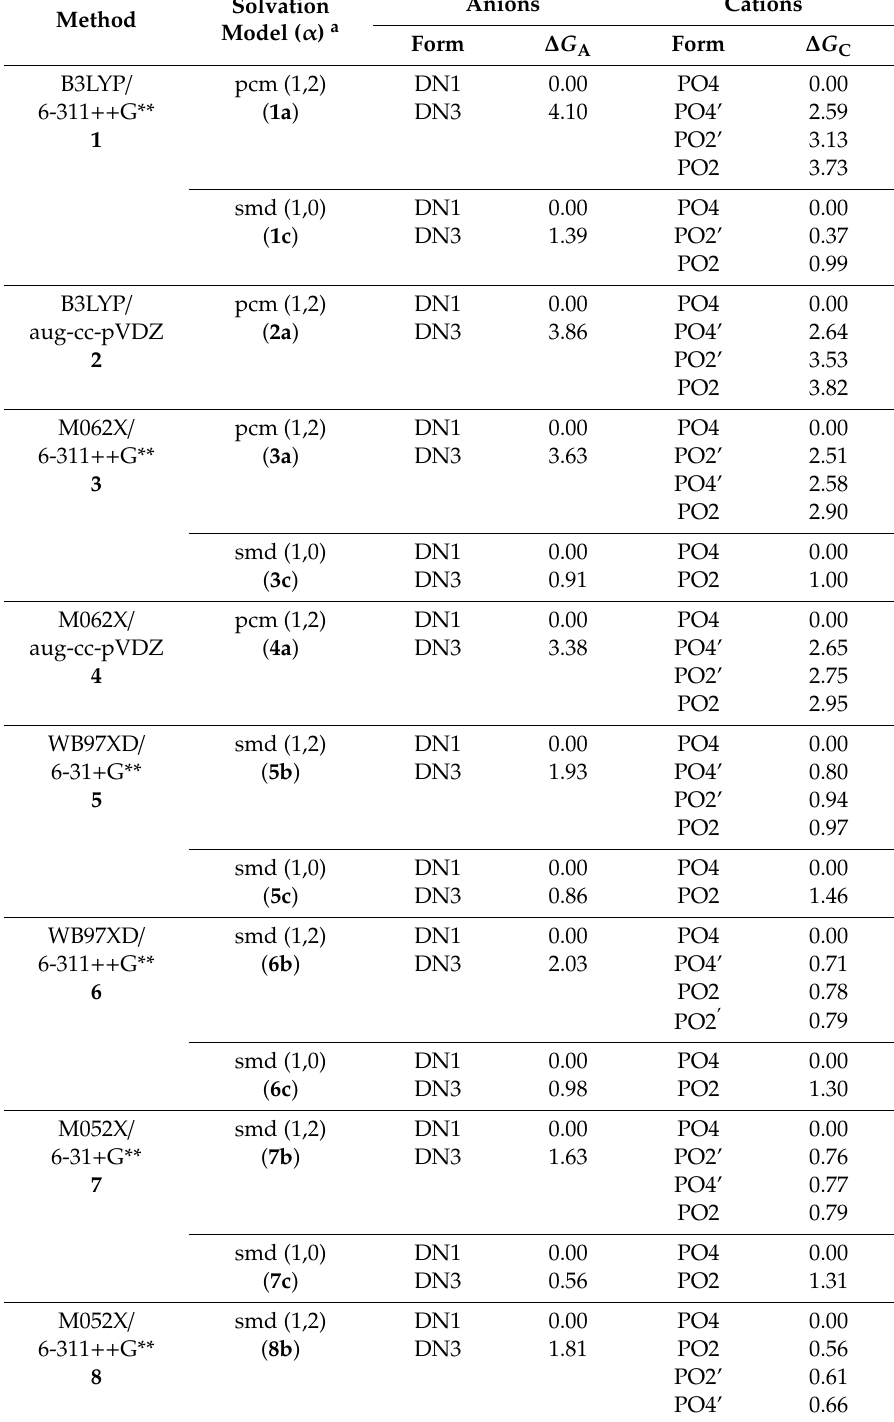
Table 5. Calculated relative energies (kcal / mol) for anionic ( ∆ G A ) and cationic ( ∆ G C ) forms of 5FU in